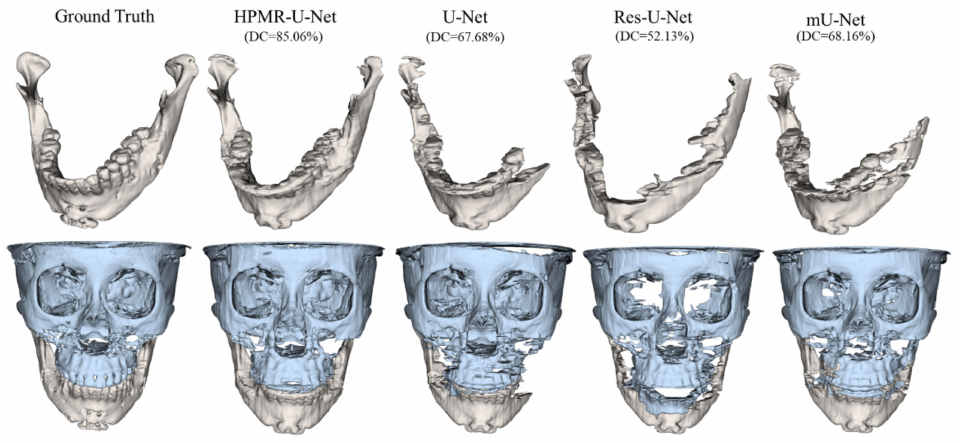
Figure 8. Sample case in CenterB dataset. White and blue indicate the mandible and maxilla,